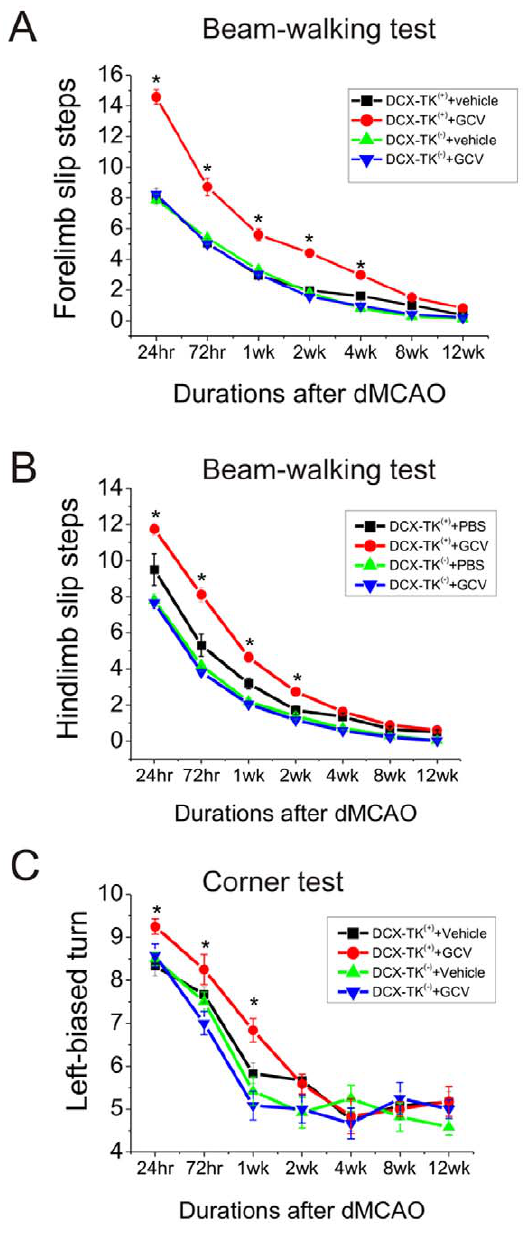
Figure 3. Beam-walking and corner testing in middle-aged DCX-TK ( 2 ) and DCX-TK ( + ) mice after dMCAO. Middle-aged DCX- TK ( 2 ) and DCX-TK ( + ) mice underwent dMCAO after treated with vehicle or GCV for 14 days, then behavioral tests were conducted at intervals over the next 12 wks (weeks). ( A ) Forelimb slip steps of Beam-walking test (higher scores correspond to more severe deficits). ( B ) Hindlimb slip steps of Beam-walking test (higher scores correspond to more severe deficits). ( C ) Scores of corner test (higher scores correspond to more severe deficits). * P ,